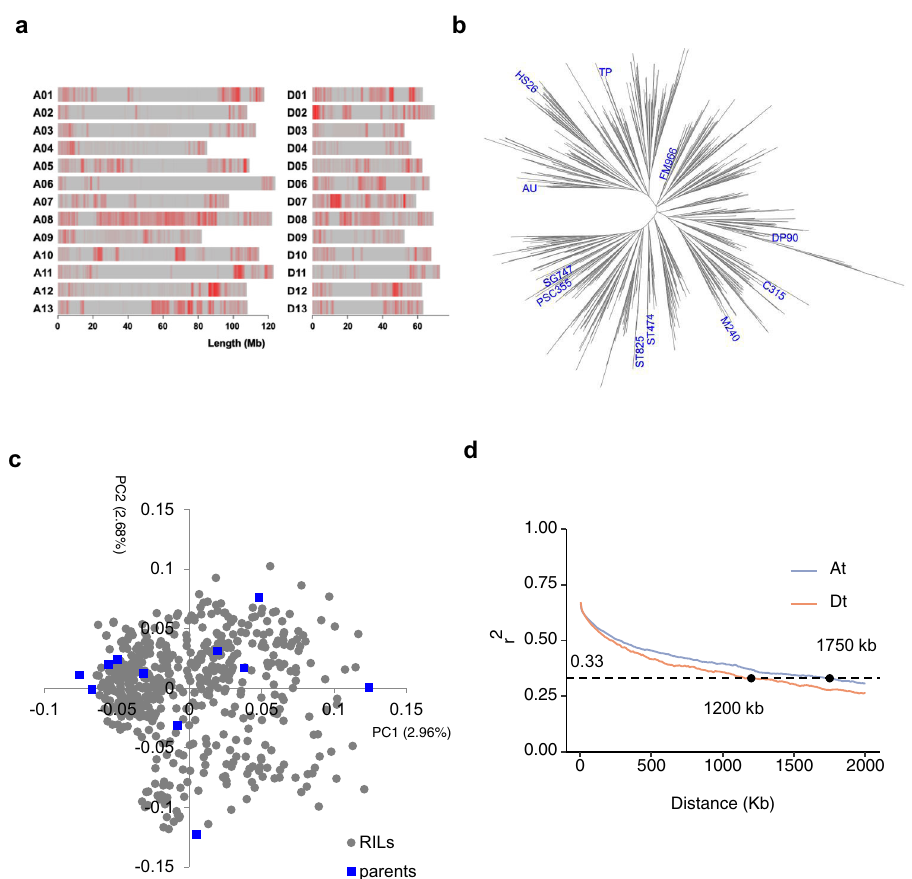
Fig. 1 Diversity in the cotton MAGIC population. a Distribution of SNPs in 26 chromosomes. b Neighbor-joining tree of the 11 founders and 550 MAGIC RILs, with founder labeled in blue. c A principal component analysis of the 11 founders and 550 MAGIC RILs using the full set of SNPs. Blue color represents parents. Gray color represents RILs. d Decay of linkage-disequilibrium (LD) in the A t and D t